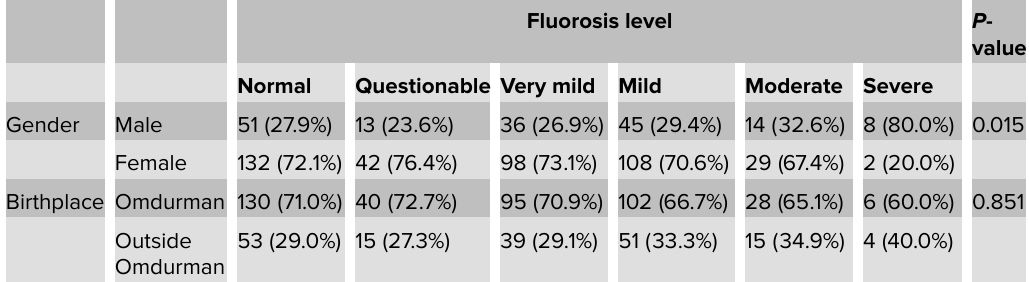
TABLE 2: Comparison of the Dean’s index with respect to the students’ gender and place of